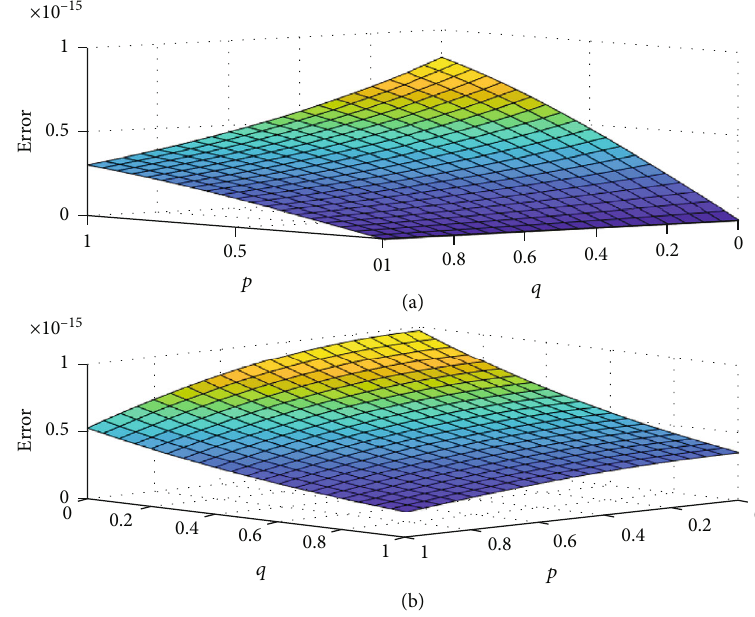
Figure 2: Charts of absolute error z (a) and v (b) with ρ = ω = υ = 1 for Example 7 when m = 6 .